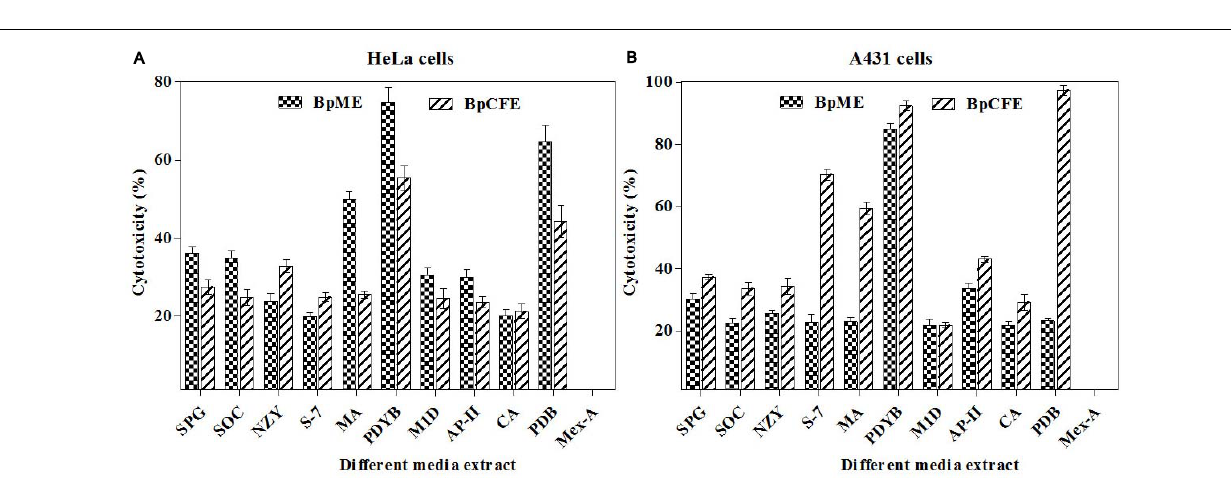
FIGURE 5 | Cytotoxic effects of B. petrensis culture extracts grown in different media on HeLa (A) and A431 (B) at 25 µ